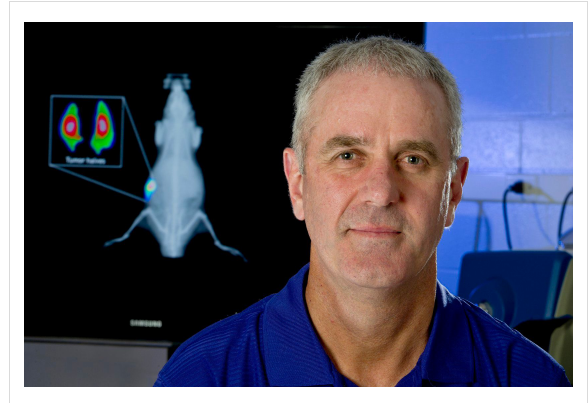
Figure 4: The author as director of the Notre Dame Integrated Imaging Facility.